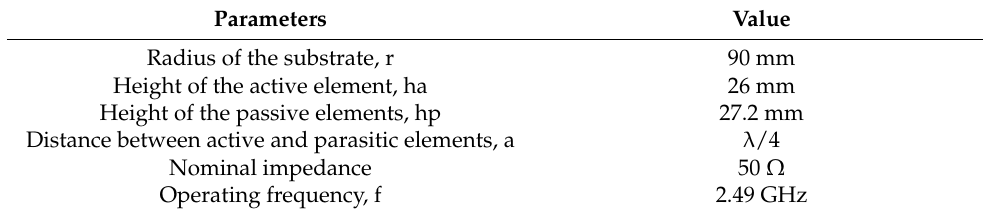
Table 1. ESPAR antenna design parameters.